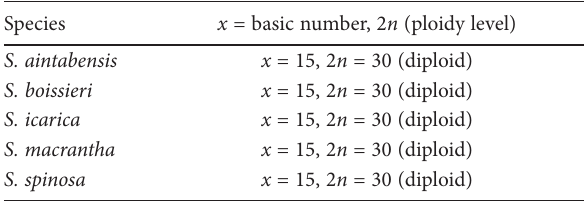
Table 2. The chromosome numbers of studied Satureja